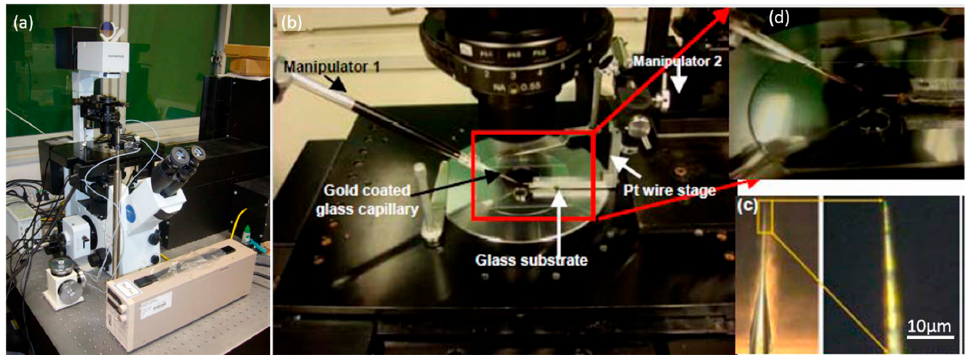
Figure 5. Laboratory equipment. ( a ) Inverted optical microscope (IX71, Olympus). ( b ) The overall view of the setup containing two manipulators, glass capillary, Pt stage, etc. ( c ) Gold-coated glass capillary with 1 μ m shaped tip. ( d ) Inset picture of glass substrate.